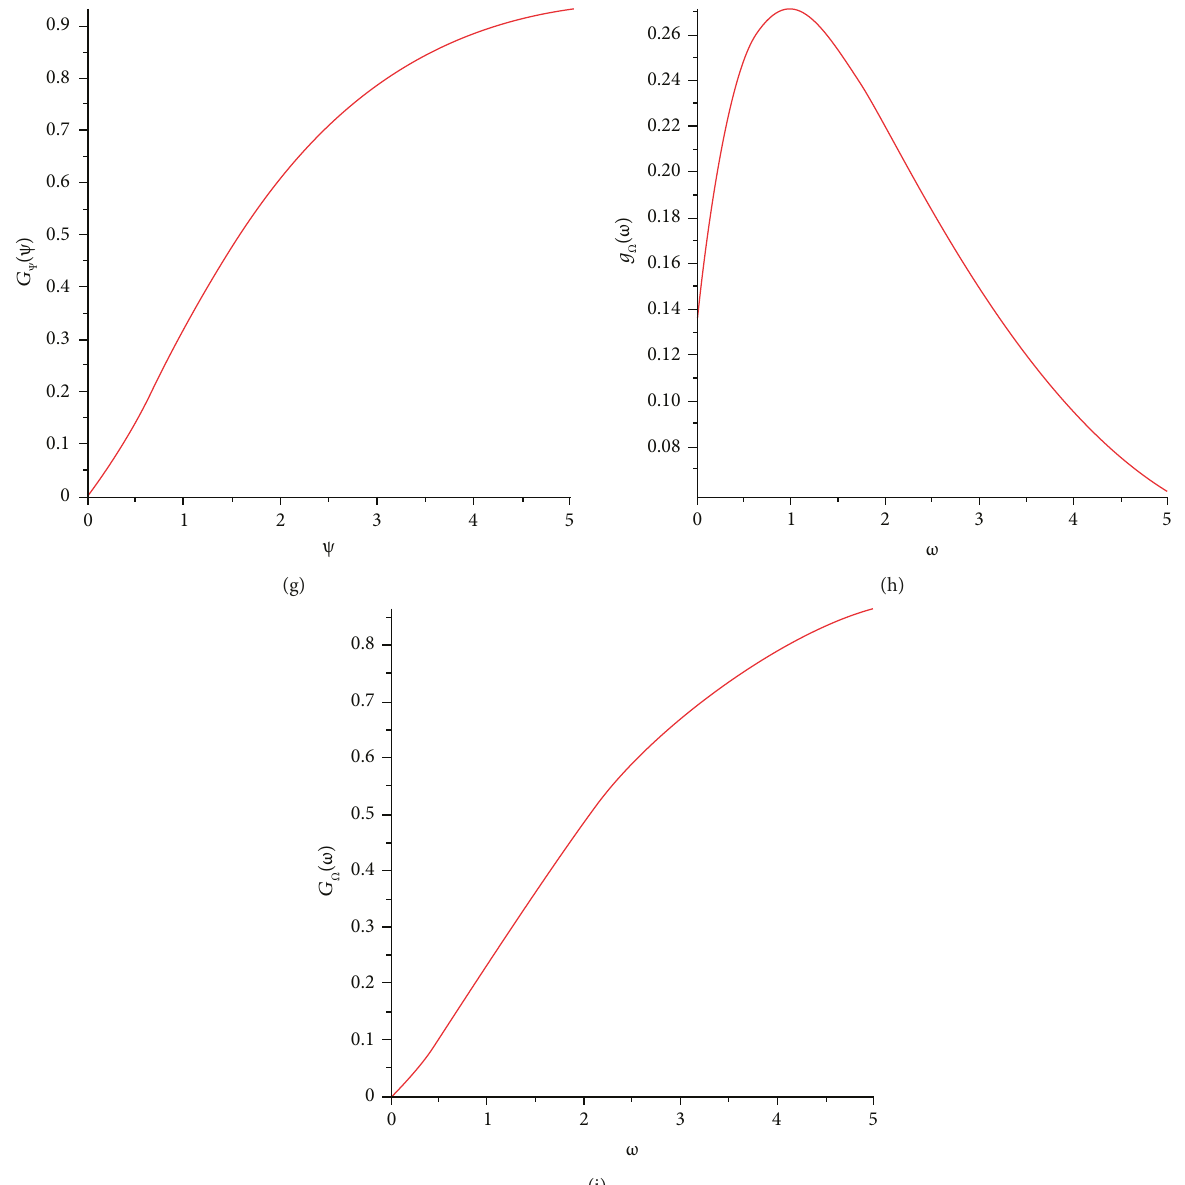
Figure 2: Statistical quantities for the set II of parameters, ( θ , ξ